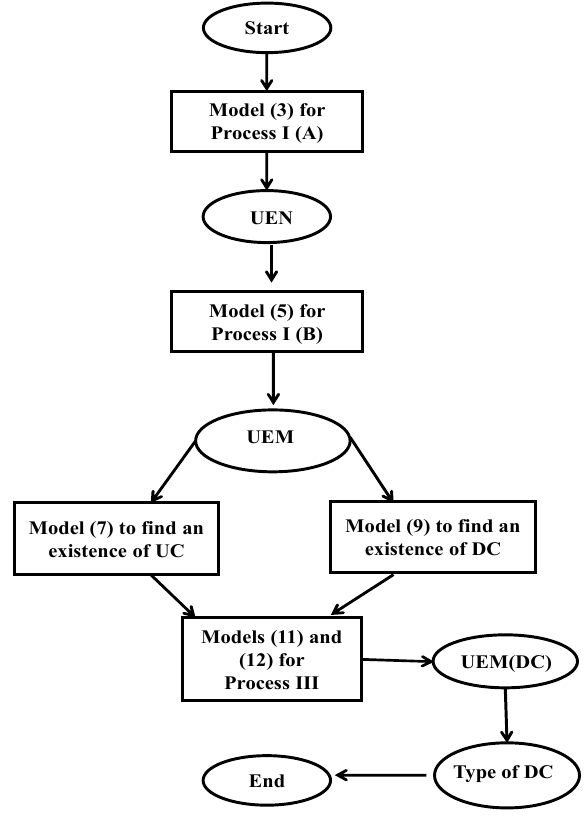
Figure 4. A computational flow for proposed assessment. (a) First, model (3) computes the degree of UEN as depicted in the process I(A). Second, model (5) calculates the degree of UEM as depicted in the process I(B). Third, the second process (II) is used to prepare the last process (III), Fourth, model (7) incorporates